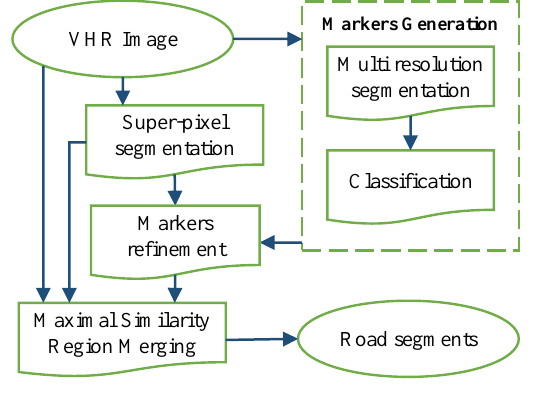
Figure 1. Flowchart of the proposed approach.